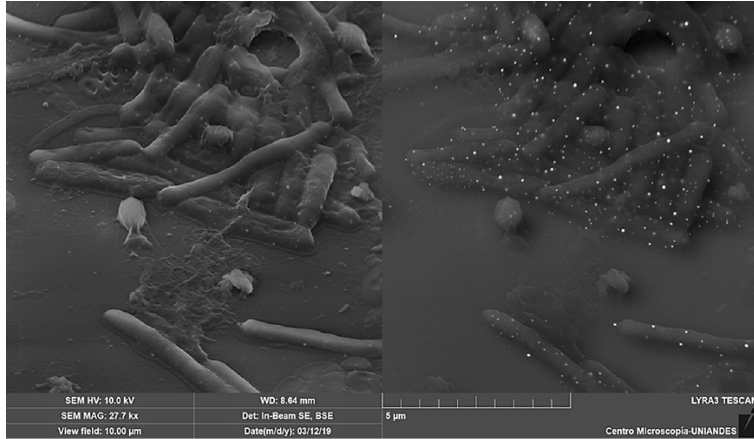
Figure 1. EDS-SEM of dead L. sphaericus III(3)7 and Ot4b31 immobilized in RH after in contact with HgCl 2 .